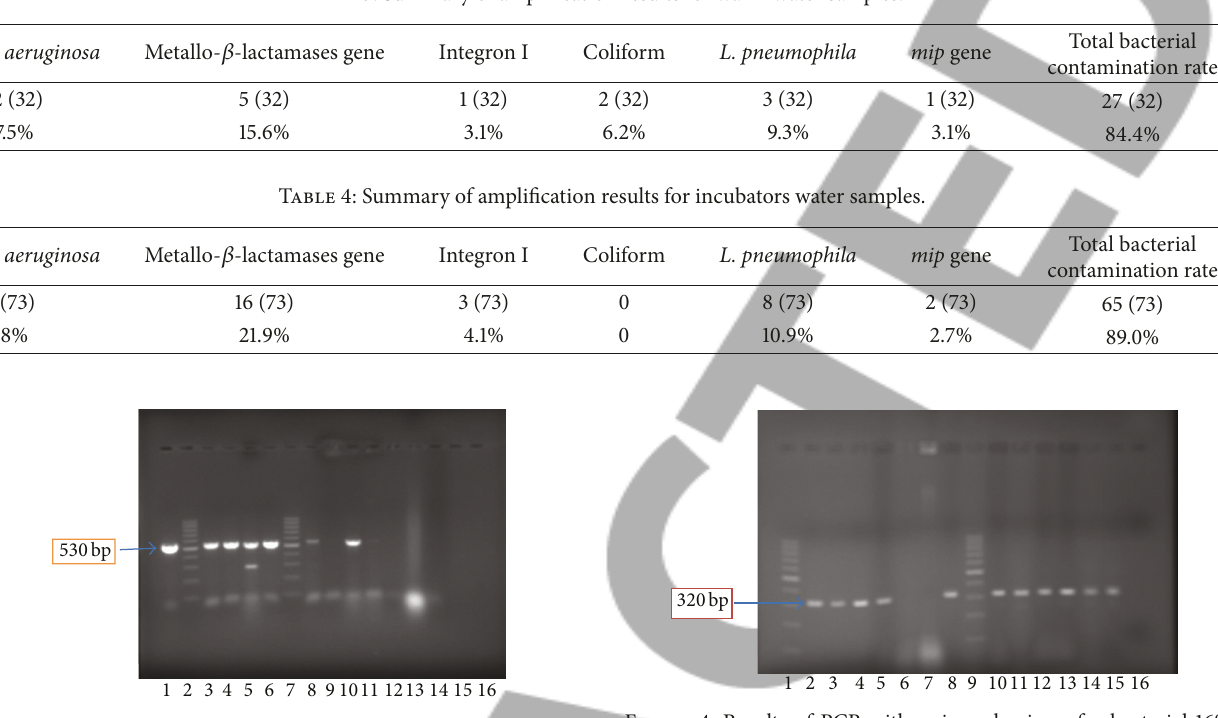
Figure 2: Results of PCR with L. pneumophila : species specific primers for 13 incubator samples. Line 1 is positive control ( L.